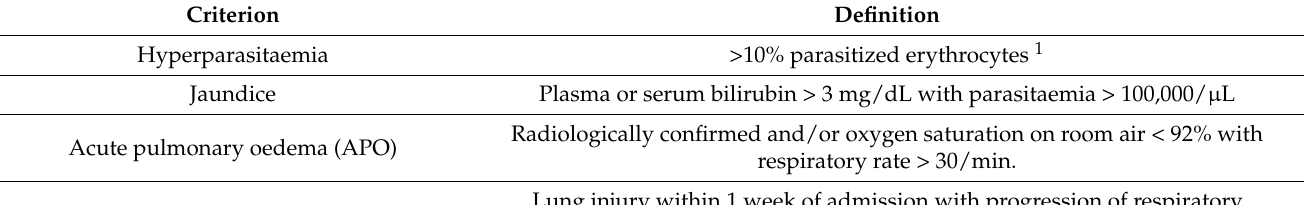
Table 1. Severe imported falciparum malaria was defined according to the 2014 World Health Organization definition with minor